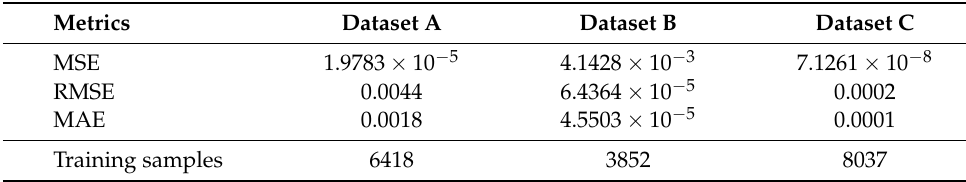
Table 5. Performance results of supercapacitor datasets: training